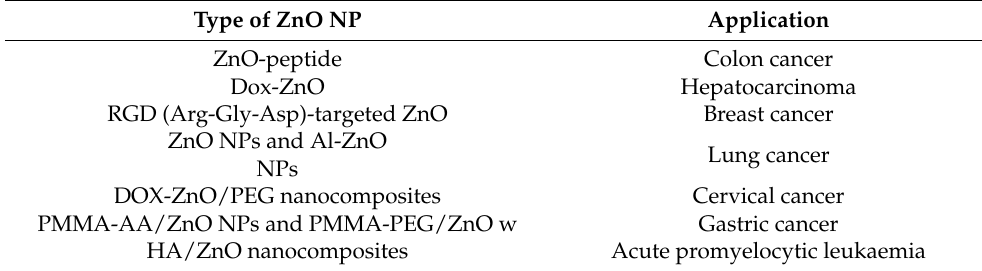
Table 3. Types and applications of ZnO NPs in cancer